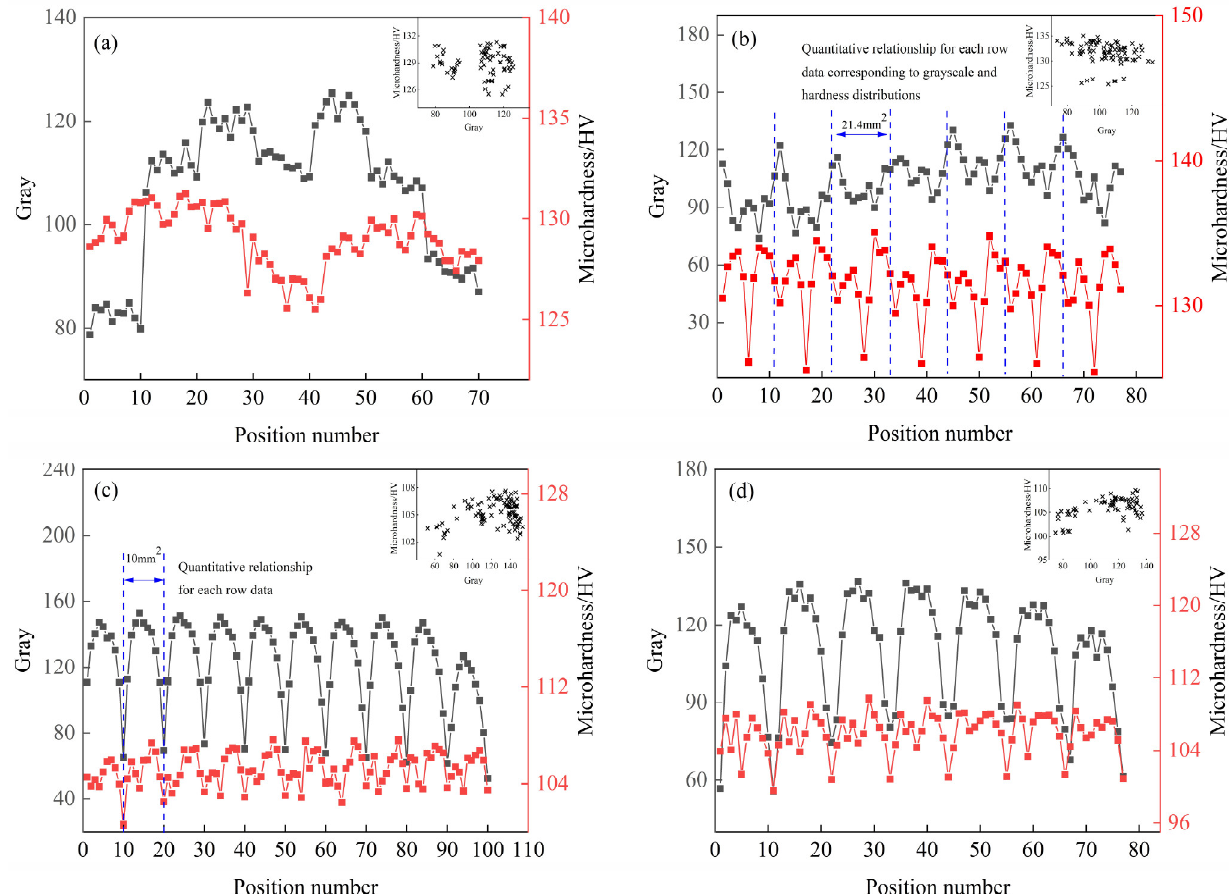
Figure 14. Statistical mapping diagram of gray and hardness data in four aluminum alloy microregion: ( a ) T4-6; ( b ) T4-15; ( c ) T5-10; ( d ) T5-15.